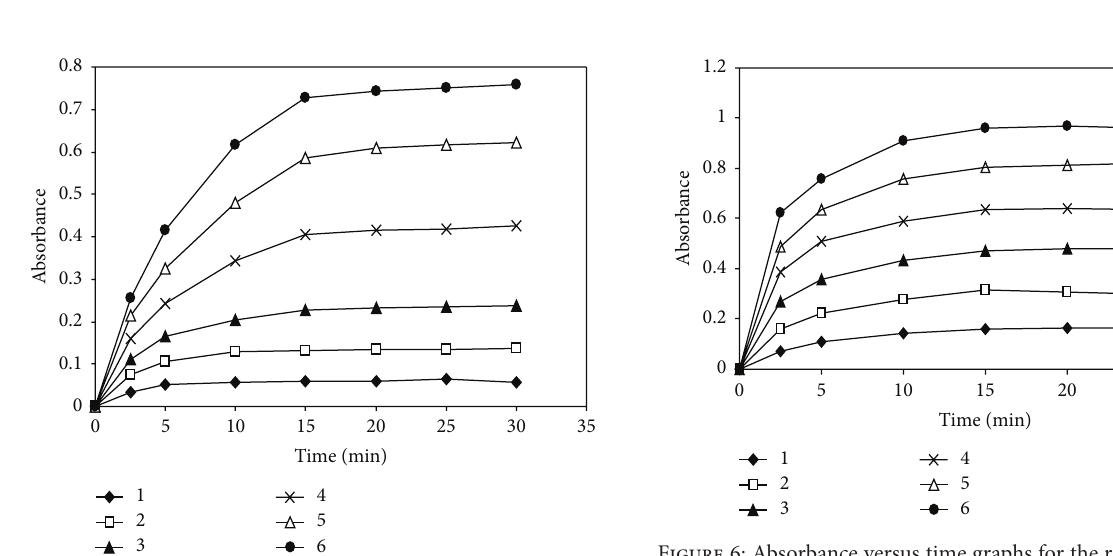
Figure 5: Absorbance versus time graphs for the reaction of GMF and NBD-Cl. Concentration of GMF: (1) 1.03 × 10 −6 , (2) 2.06 × 10 −6 ,